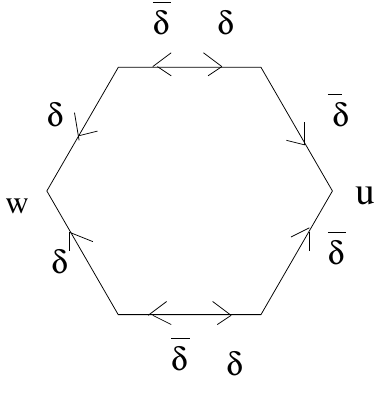
Figure 22 . Skeleton graph for (cid:8) 23 ;A (cid:0) 2(cid:8) 12 ;A .